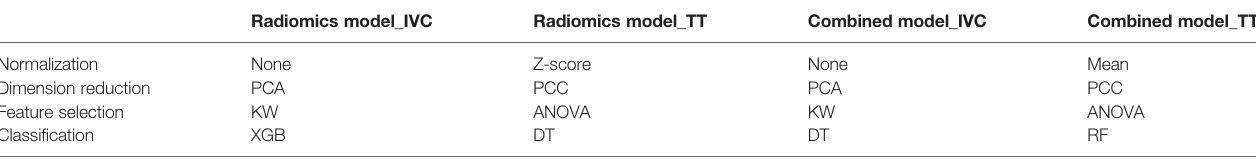
TABLE 3 | Modeling pipelines of the radiomics models and combined